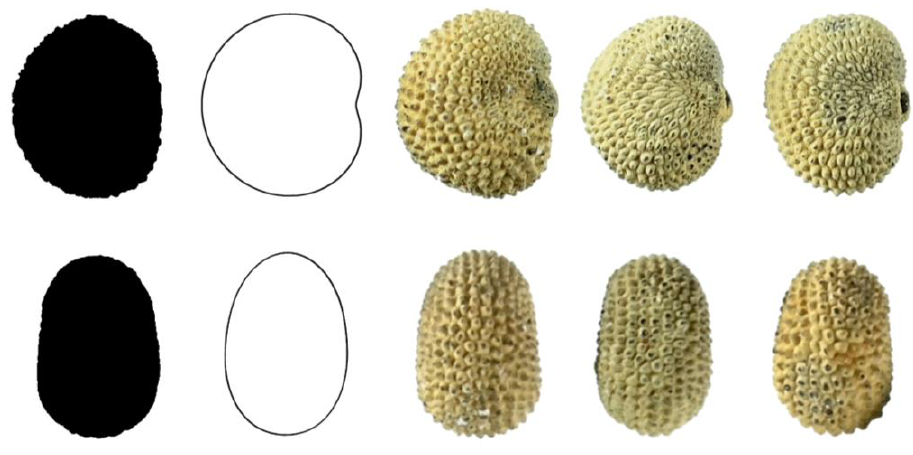
Figure 5. Silene marizii : average silhouettes (left), the models giving best scores with 20 seeds (LM2 and DM2), and three representative images for the lateral (above) and dorsal (below) seed views. Bar represents 1 mm.